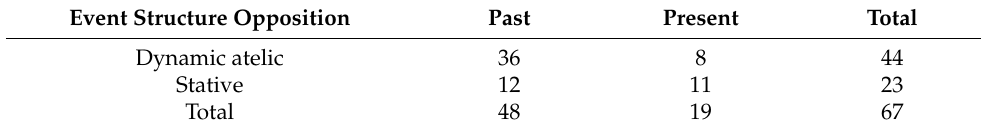
Table 10. Temporal anchoring of dynamic vs. stative utterances in all temporal